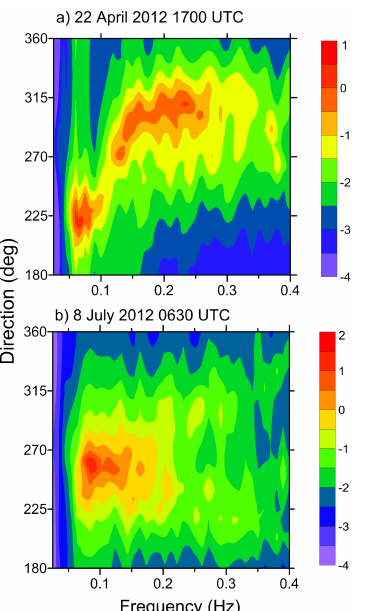
Figure 6. Typical directional wave spectrum during the (a) non- monsoon and (b) monsoon period. Contours presented are the spec- tral energy density (m 2 Hz − 1 deg − 1 ) in logarithmic scale.